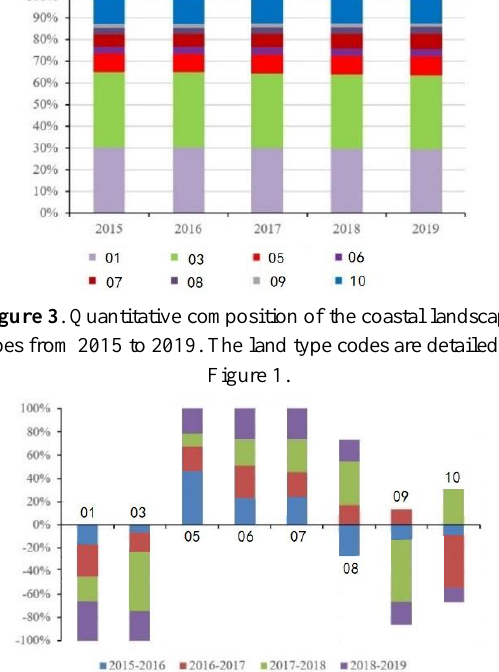
Figure 4 . Annual change rate of coastal landscape. The land type codes are detailed in Figure 1.